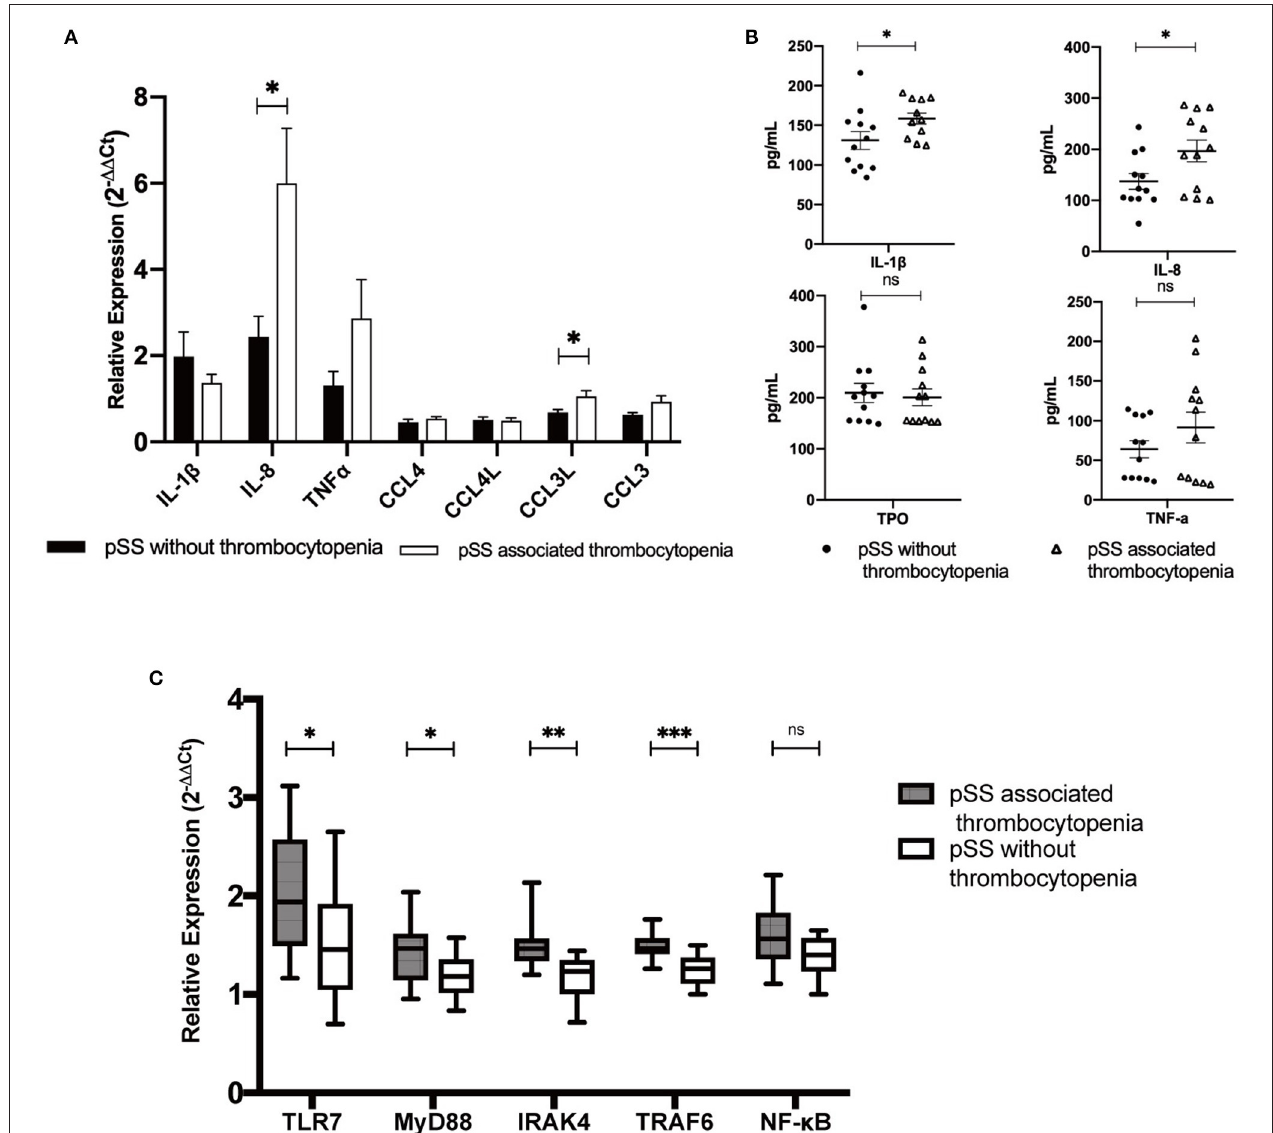
FIGURE 3 | Hub genes expression, upregulation of Toll-like receptor (TLR) 7 and its downstream signaling molecules in B-cell and serum in pSS patients with or without thrombocytopenia in the validation cohort. (A) mRNA relative expression levels of 7 hub genes in B cells determined by real-time polymerase chain reaction (RT-PCR). Compared to that in pSS patients without thrombocytopenia, the relative expression of interleukin (IL)-8 mRNA and CCL3L in B-lymphocytes in patients with pSS-associated thrombocytopenia was increased. (B) Serum level of IL-1 β , IL-8, thrombopoietin (TPO) and TNF α . (C) Upregulation of TLR7 and its downstream signaling molecules in patients with pSS associated thrombocytopenia compared to those in pSS patients without thrombocytopenia (* p < 0.05, ** p < 0.01, *** p < 0.001; ns, not